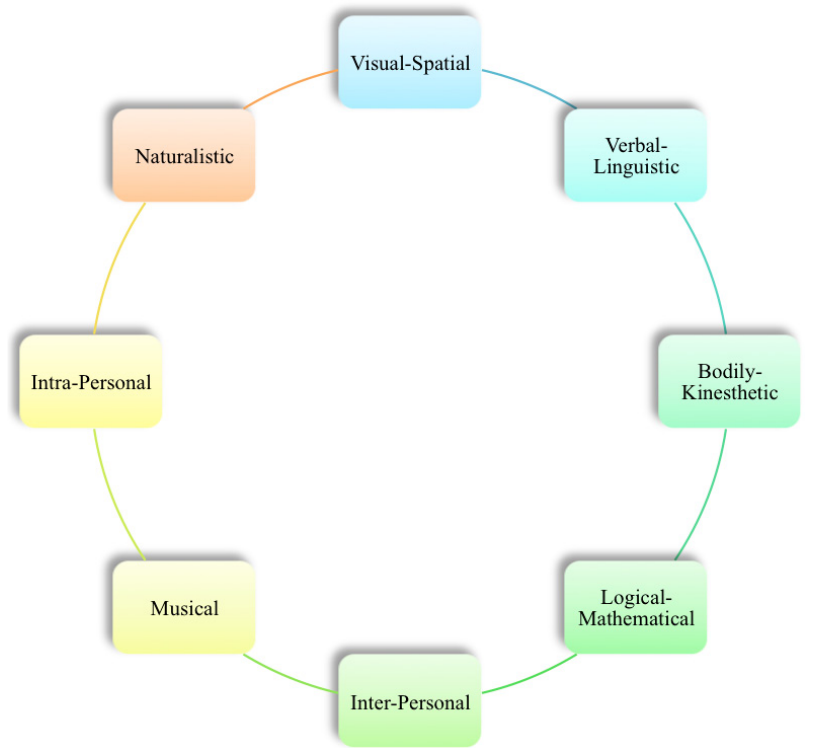
Fig. 3. The Eight Inteligences: Visual-Spatial Intelligence is related to the ability to perceive visual-spatial stimuli. Verbal-Linguistic Intelligence concerns paricular skills in different spoken and written functions of language. Bodily-Kinesthetic Intelligence refers to the ability to control body movements and skillful handling of objects. Logical-Mathematical Intelligence refers to arithmetic skills and mathematical thinking, as well as the ability to handle logical and numerical patterns. Inter-Personal Intelligence intelligence contains abilities to discern the purposes, the motivations and the moods of the others. Intra-Personal Intelligence is related to the ability of an individual to control his/her own feeling and self-knowledge. Musical Intelligence involves sensitivity to sounds, abilities to appreciate rhythm, execute and composite musical structures. Naturalistic Intelligence refers to the ability of an individual to detect and connect different elements in nature as well as the ability to recognize natural forms and